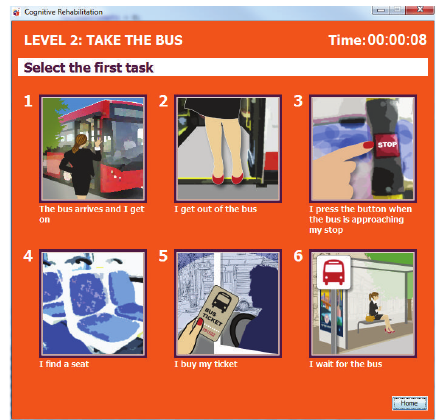
Figure 9: Daily-life activities game (level 2)